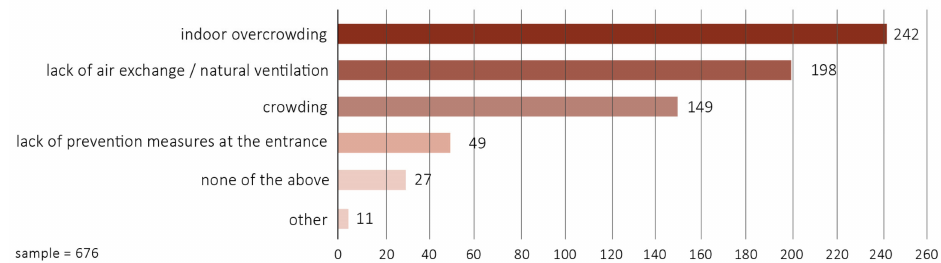
Figure 12. Graphics illustrating the users’ opinions about the most worrying conditions in an indoor environment (case studies survey research). Own